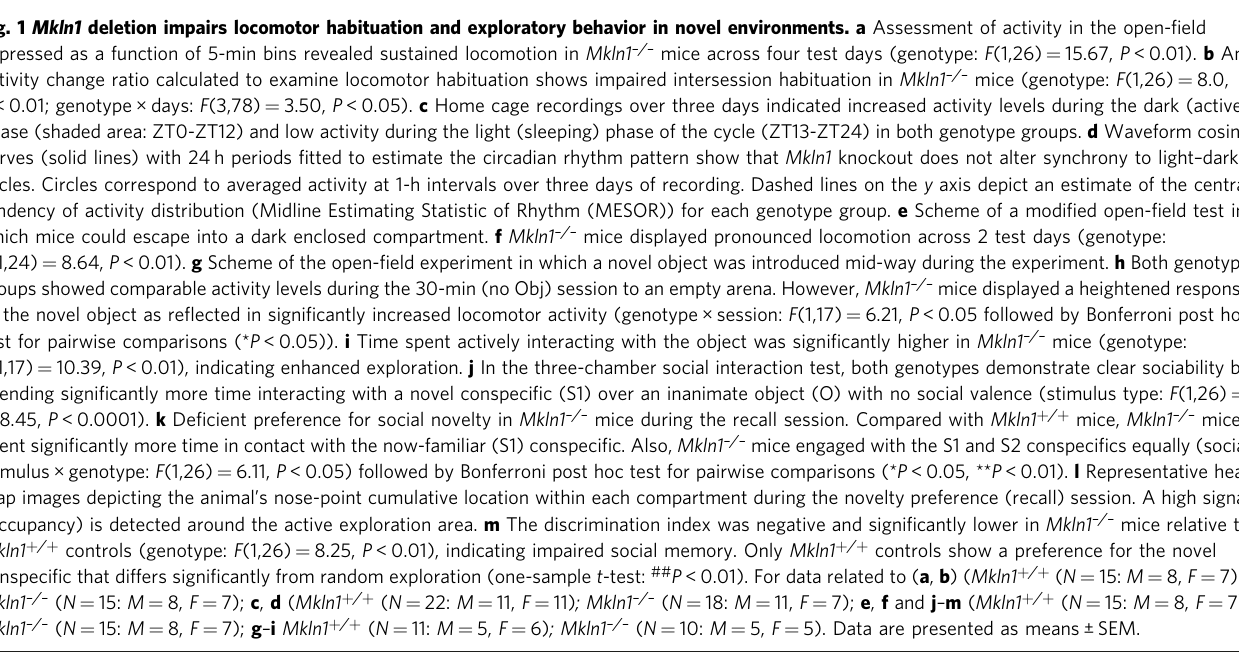
Fig. 1 Mkln1 deletion impairs locomotor habituation and exploratory behavior in novel environments. a Assessment of activity in the open- fi eld expressed as a function of 5-min bins revealed sustained locomotion in Mkln1 – / – mice across four test days (genotype: F (1,26) = 15.67, P < 0.01). b An activity change ratio calculated to examine locomotor habituation shows impaired intersession habituation in Mkln1 – / – mice (genotype: F (1,26) = 8.0, P < 0.01; genotype × days: F (3,78) = 3.50, P < 0.05). c Home cage recordings over three days indicated increased activity levels during the dark (active) phase (shaded area: ZT0-ZT12) and low activity during the light (sleeping) phase of the cycle (ZT13-ZT24) in both genotype groups. d Waveform cosine curves (solid lines) with 24 h periods fi tted to estimate the circadian rhythm pattern show that Mkln1 knockout does not alter synchrony to light – dark cycles. Circles correspond to averaged activity at 1-h intervals over three days of recording. Dashed lines on the y axis depict an estimate of the central tendency of activity distribution (Midline Estimating Statistic of Rhythm (MESOR)) for each genotype group. e Scheme of a modi fi ed open- fi eld test in which mice could escape into a dark enclosed compartment. f Mkln1 – / – mice displayed pronounced locomotion across 2 test days (genotype: F (1,24) = 8.64, P < 0.01). g Scheme of the open- fi eld experiment in which a novel object was introduced mid-way during the experiment. h Both